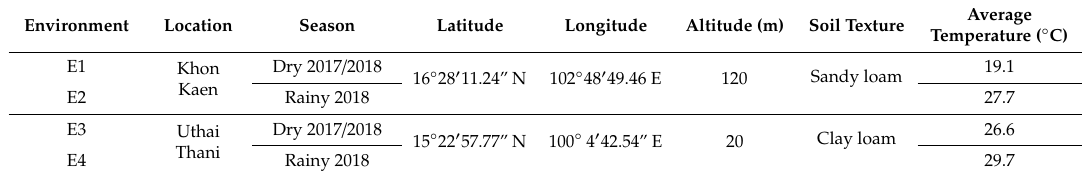
Table 2. Description of four experimental sites in the study.